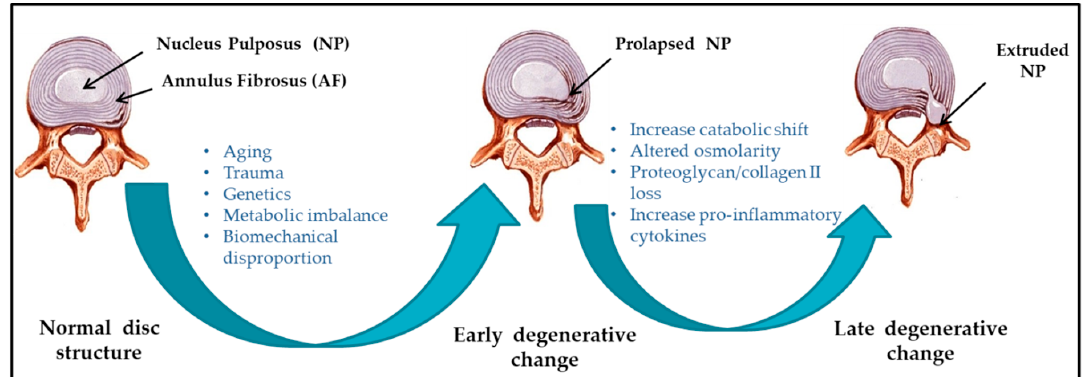
Figure 1 . Schematic illustration of intervertebral disc (IVD) pathophysiology during